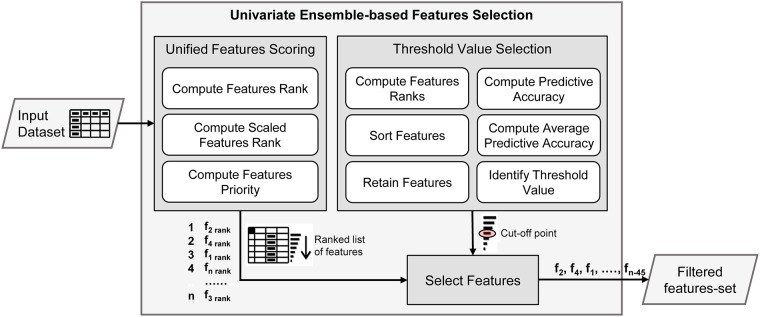
uEFS methodology.